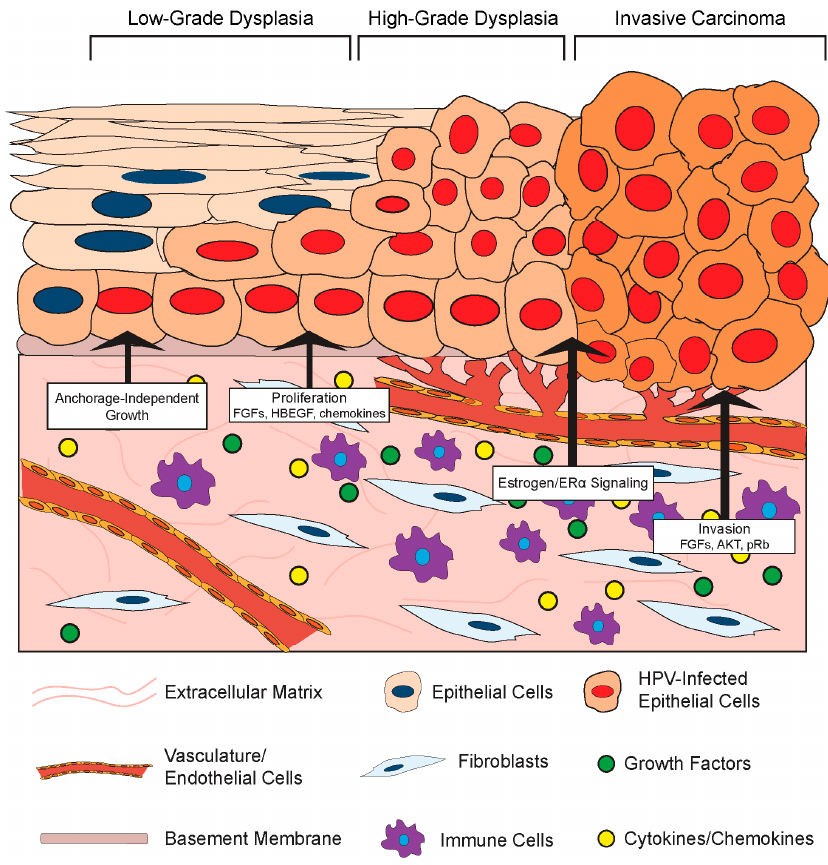
Figure 3. Effects of the stroma on HPV-positive epithelium. The HPV-infected epithelium undergoes neoplastic progression from low-grade to high-grade dysplasia and eventually invasive carcinoma. Key stromal-to-epithelial communication events between the stroma and the HPV-positive epithelium, as well as the reported paracrine factors involved in these processes, are depicted (large black arrows). The location of signaling events within the process of neoplastic progression is not necessarily reflective of their temporal activities. ER α : estrogen receptor α ; HBEGF: heparin-binding epidermal growth factor-like growth factor; pRb: retinoblastoma protein.